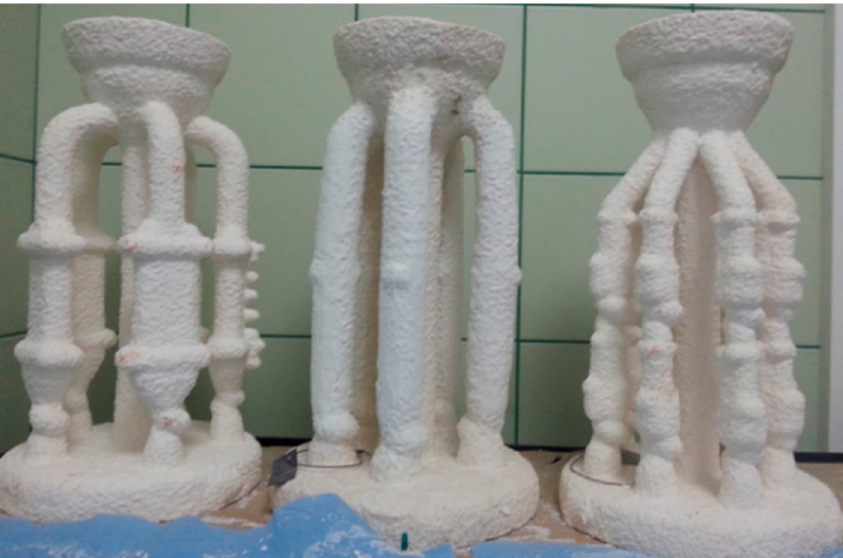
Figure 19. Examples of corundum ceramic moulds obtained with Ludox AM and Remasol binders.